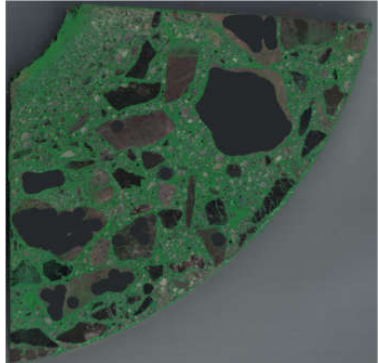
Figure 6. Image of sample after segmentation procedure Step 2.